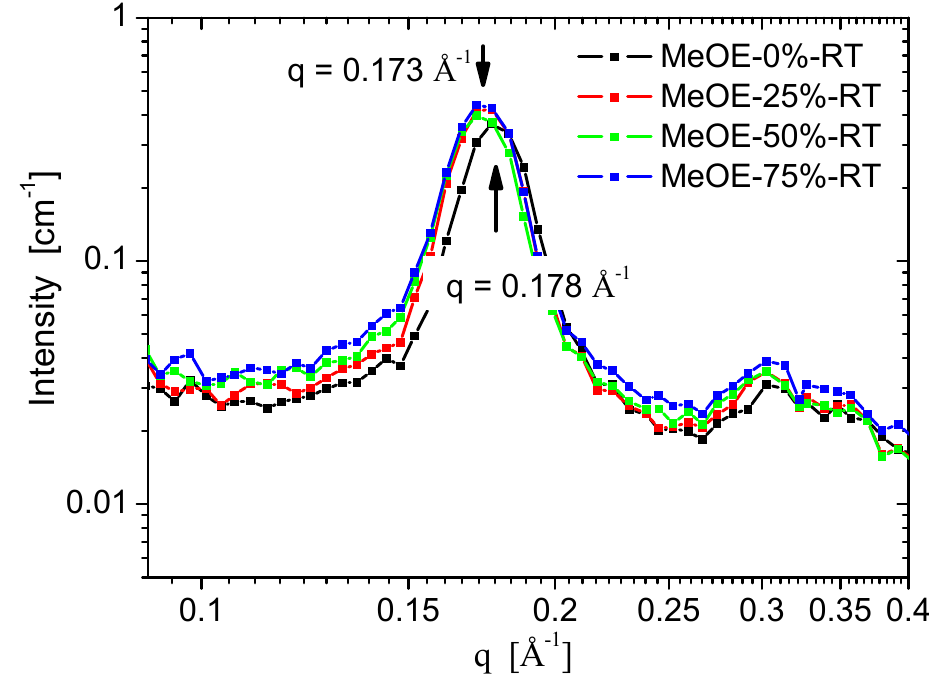
Figure 7. Variation of the first diffraction peak position with the content of 2-methoxyethanol in the solvent mixture.